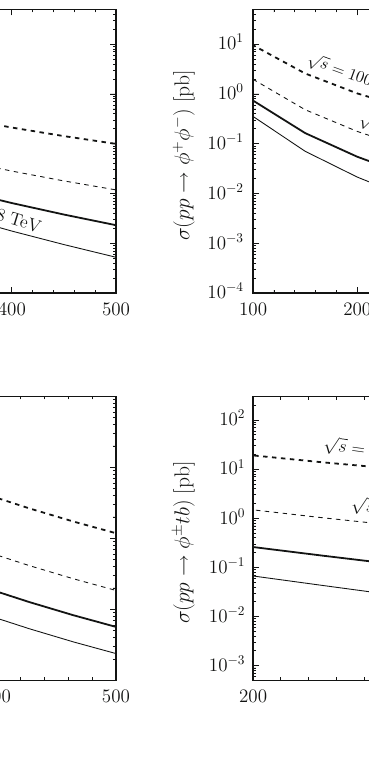
we have computed the corresponding ratio in MadGraph , by using the Higgs EFT of the ggHFullLoop model. This ratio turns out to be a good approximation of the ratio in the full theory; see Ref.